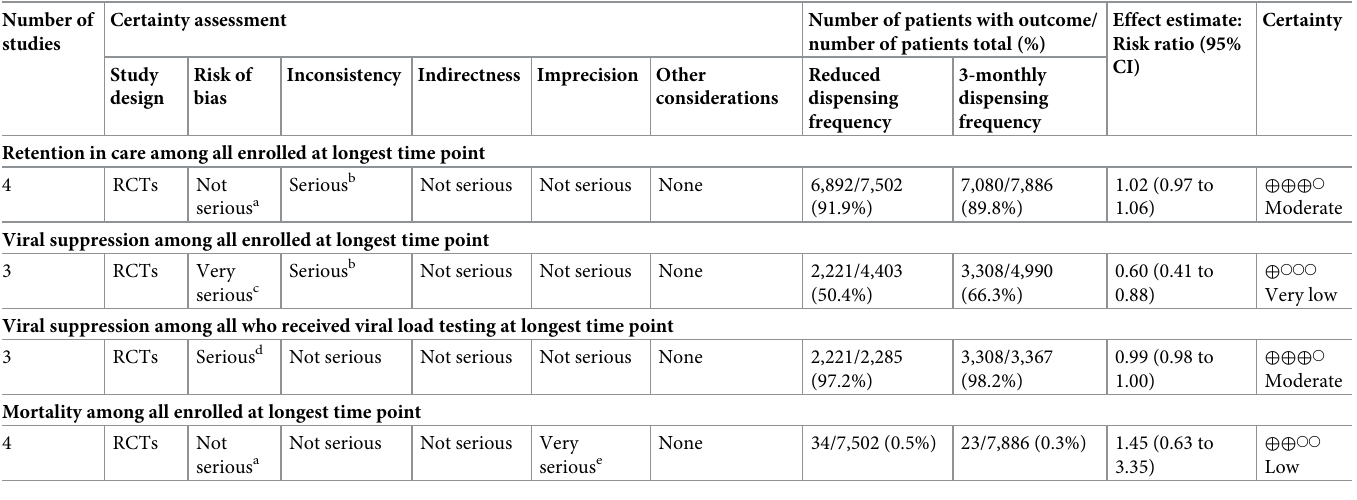
Table 7. Review evidence certainty assessment (GRADE): Reduced ART dispensing (6-monthly) versus 3-monthly ART dispensing. Number of Certainty assessment Number of patients with outcome/ studies